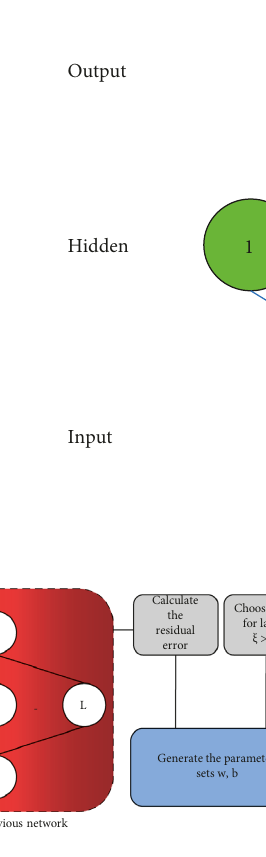
Figure 3: Algorithm